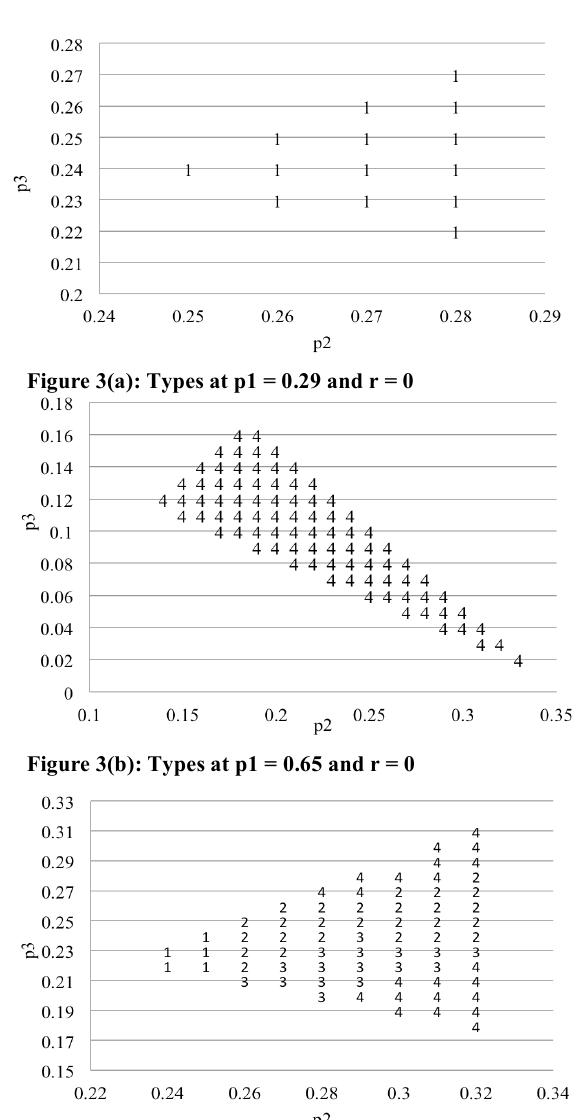
Figure 4: Types at p1 = 0.33 and r =